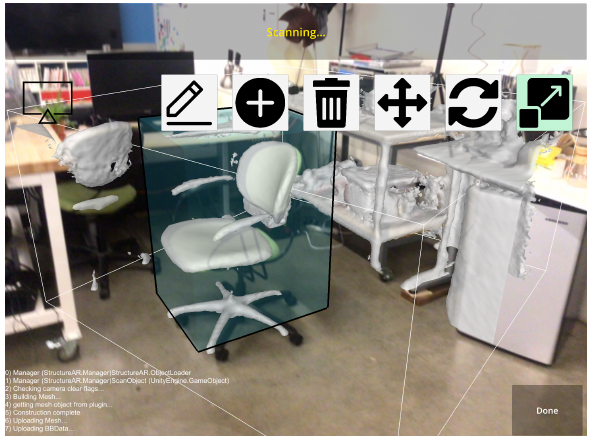
Figure 3: Screenshot of the application in action: A scanned mesh, shown in white, is superimposed on top of camera feed in real-time. A bounding box, shown in translucent blue, has been placed around the